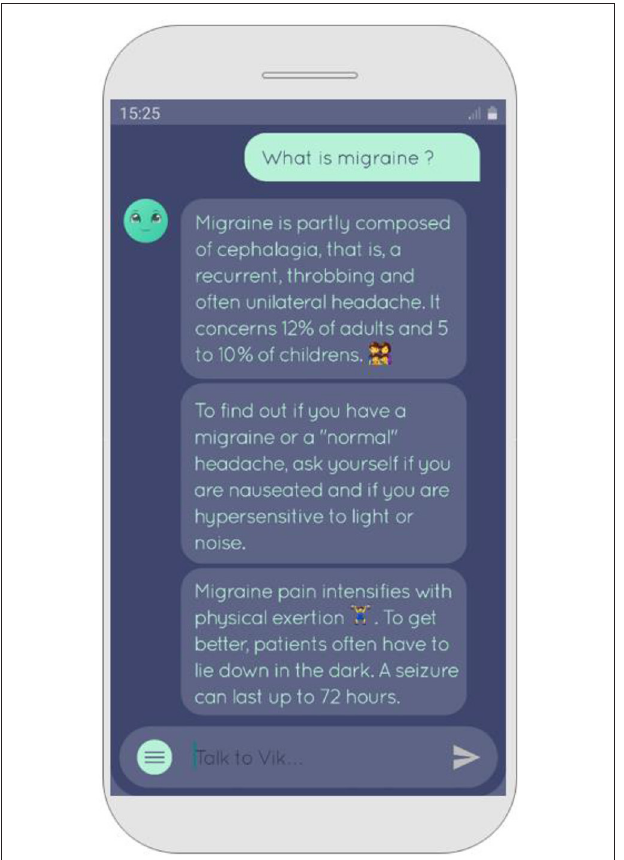
FIGURE 2 | Chatbot’s interface.